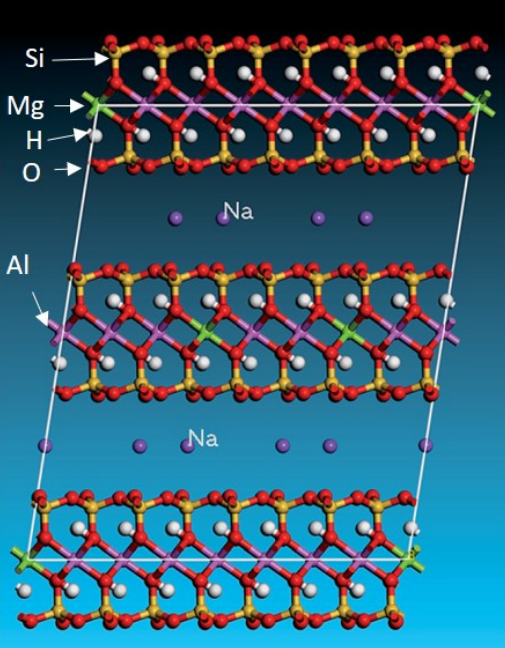
Figure 3. Molecular structure of Na-smectite. This image was taken from Li et al. [38].